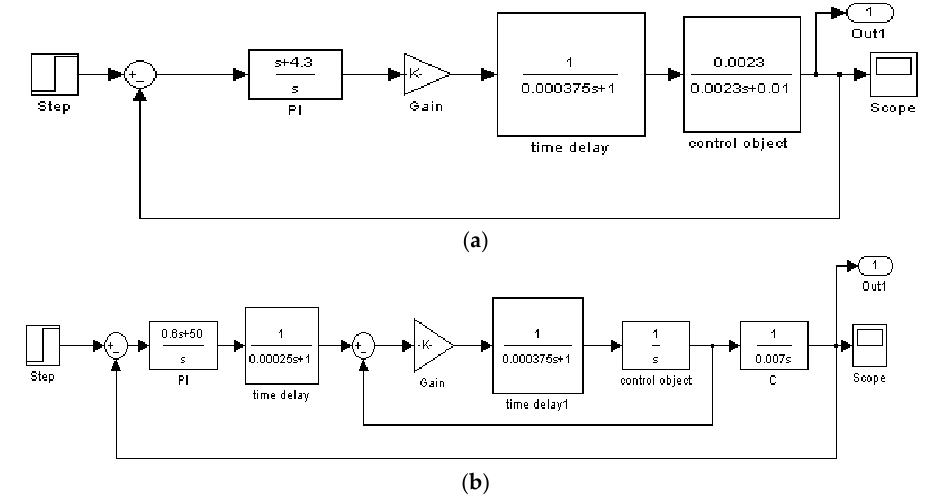
Figure 10. ( a ) Dynamic simulation model of current loop; ( b ) dynamic simulation model of voltage loop.